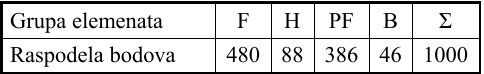
Grupe elemenata sa raspodelom bodova